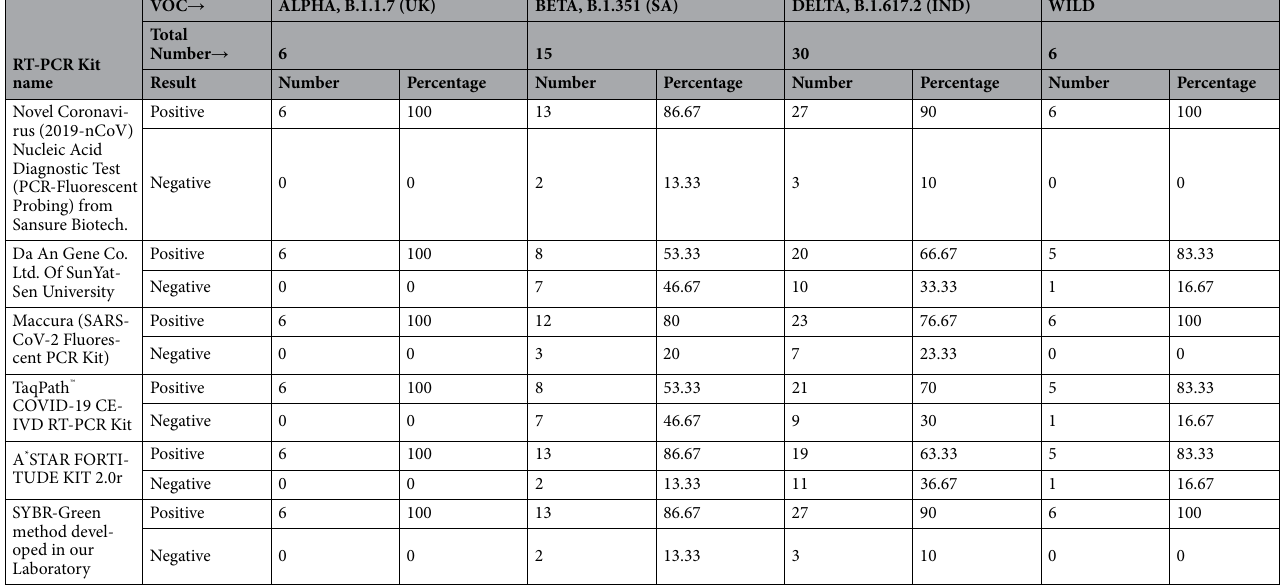
Table 2. SARS-CoV-2 Variant-wise detection result and